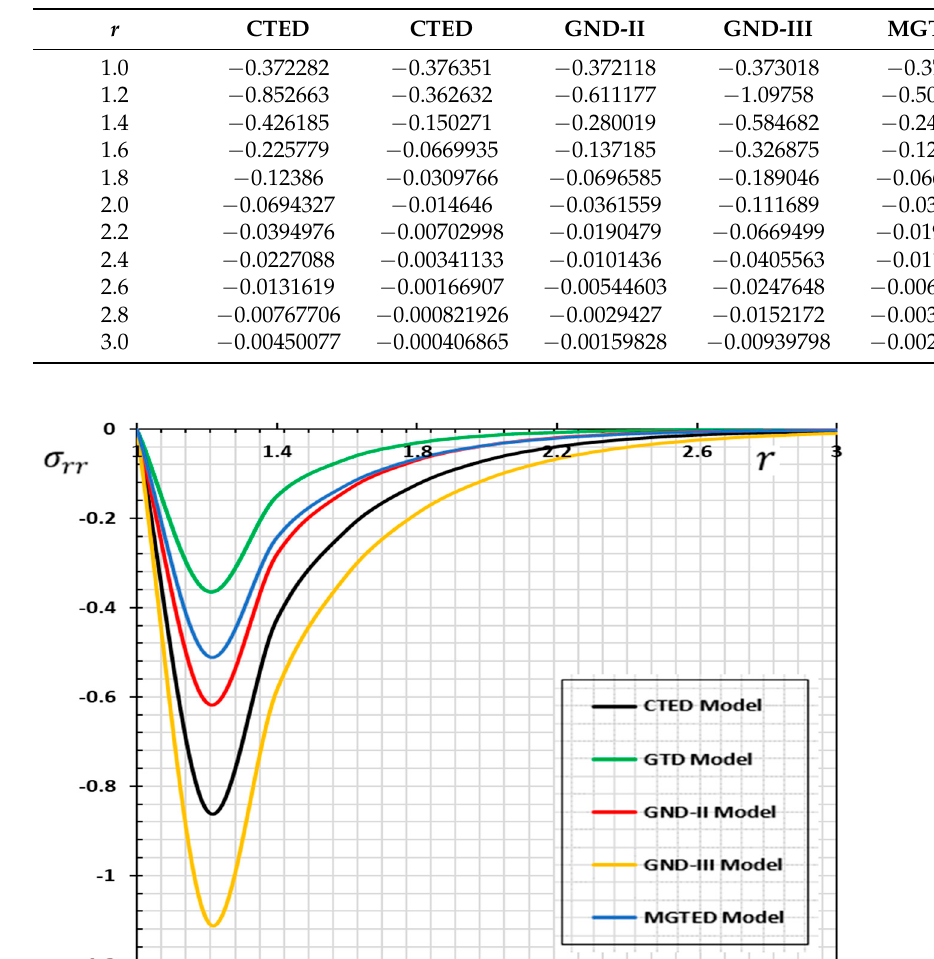
Table 4. The hoop stress σ ΘΘ for different thermo-diffusion models.